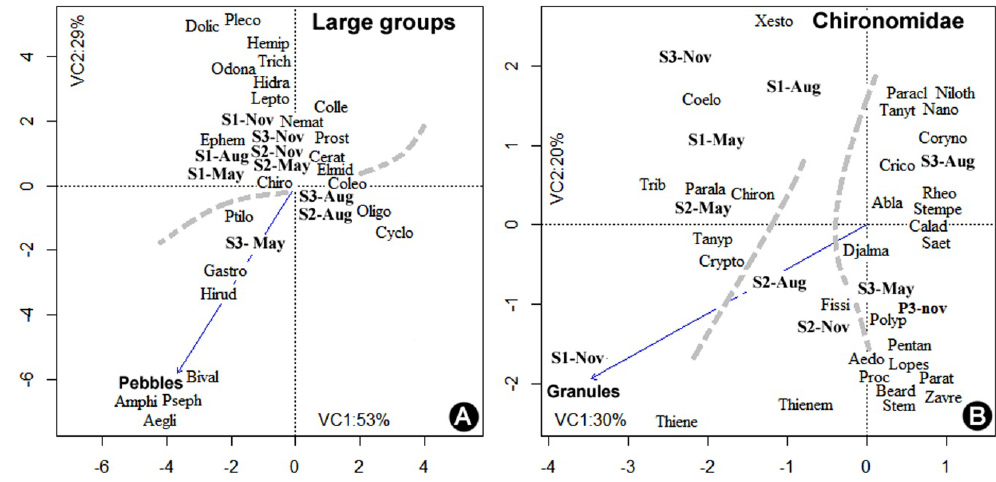
Figure 5. CCA performed to correlate abundances of benthic major groups (A) and Chironomidae (B) with the granulometric data. For captions of taxa see Table 2, and for particle size variables see Figure Table 2. List of taxa, divided in large groups and Chironomidae genus, collected at three samples sites of the Jordão River (PR), with its abbreviations for posterior statistical analysis.